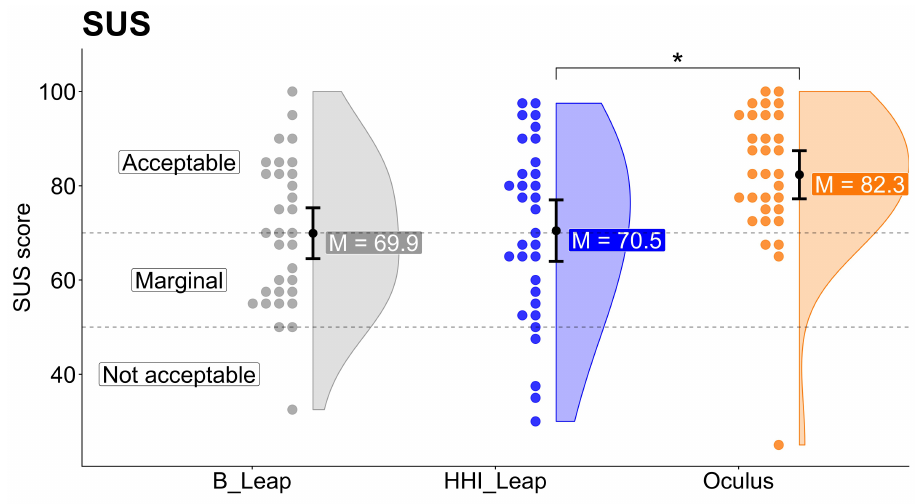
Figure 9. Usability scores (System Usability Scale, SUS) by interface, with means and 95% confidence intervals, individual participant scores (colored dots), smoothed density distributions, results of paired-samples t -tests and scoring categories [28]. * = p <